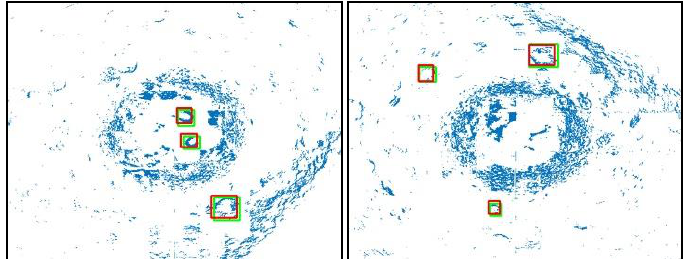
Figure 9. Results for 2D detection.